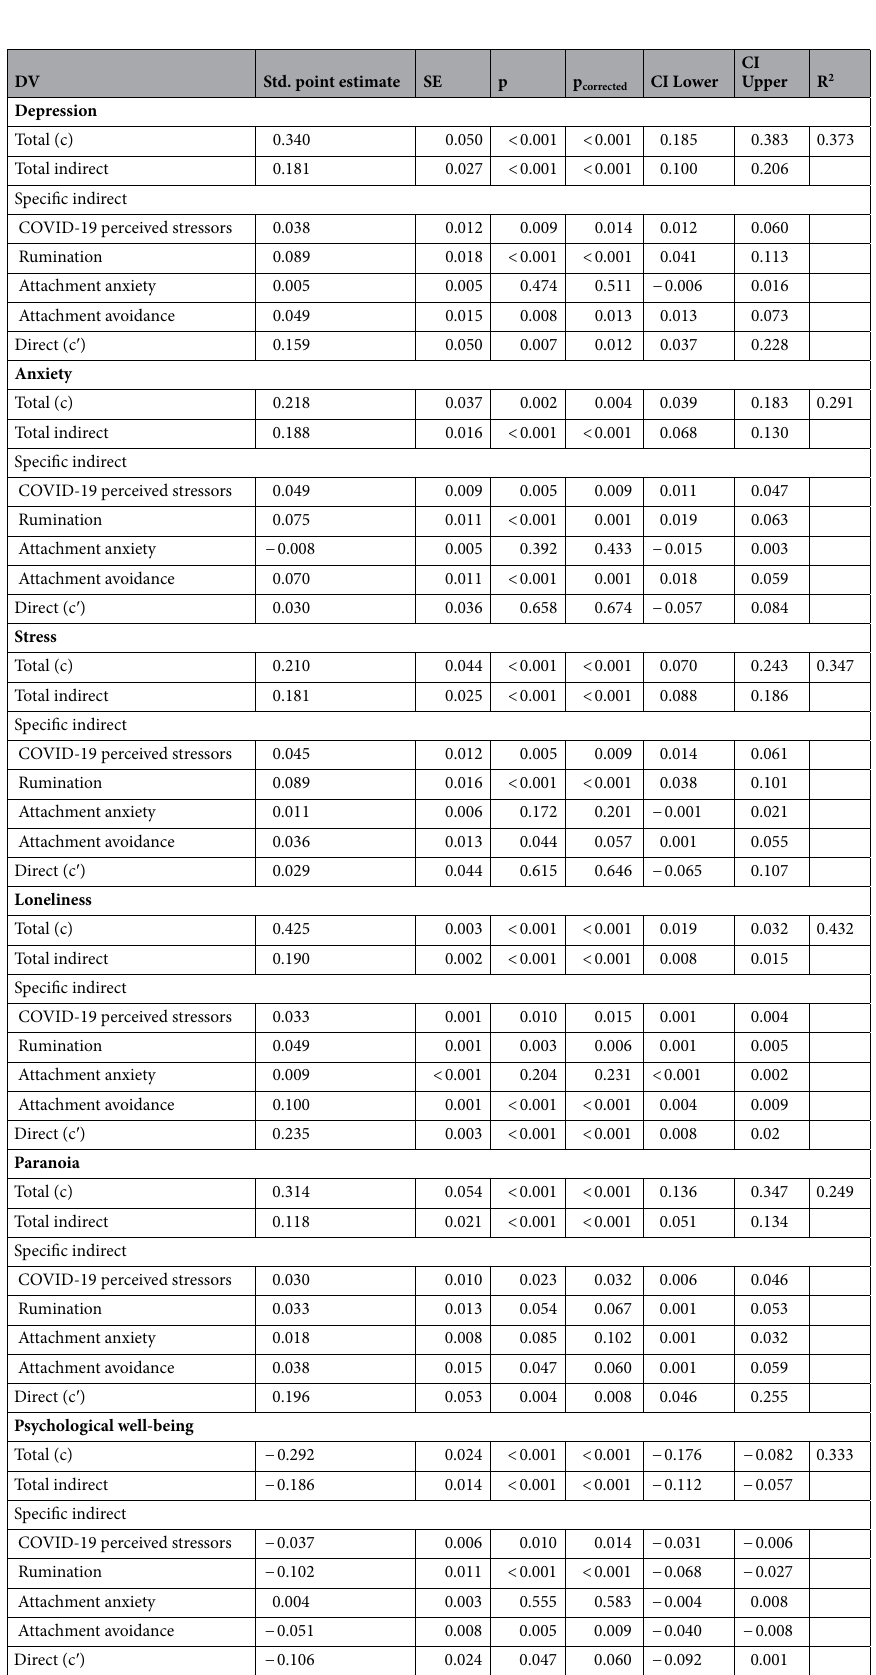
Table 3. Multiple mediation models with standardised bootstrap intervals. Depicted are total, total indirect, specific indirect, and direct effects of the different multiple mediation models. DV dependent variable, CI confidence interval (bootstrapped), Std. standardised, P corrected false discovery rate corrected p